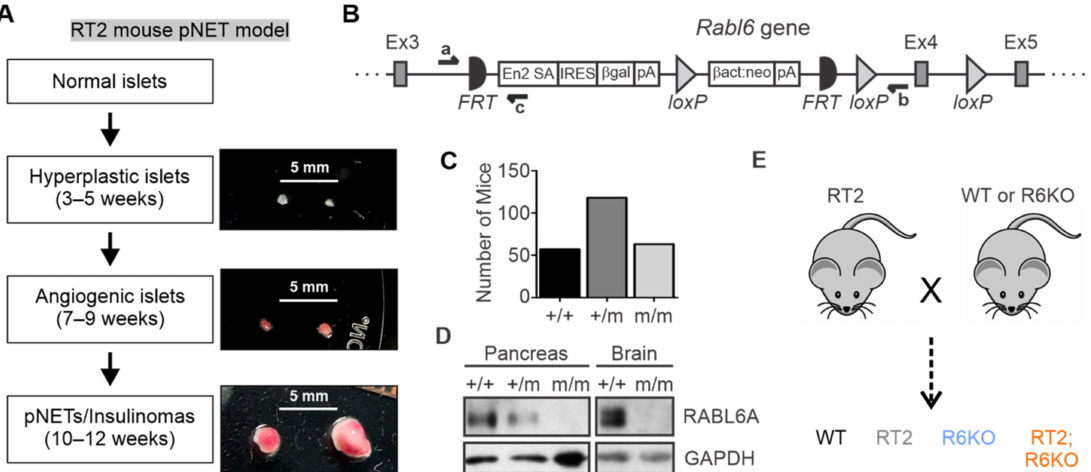
Figure 1. Description of the RT2 insulinoma and Rabl6 deficient mouse models. ( A ) Schematic outlining the sequential progression of islet transformation into functional pNETs (insulinomas) in RT2 mice. Time in parentheses represent the age of RT2 mice when the indicated islets are first observed. Right: Images of each type of lesion (with scale bars) isolated from a 12-week-old RT2 male. ( B ) Diagram of the targeted Rabl6 gene locus (exons 3–5 shown) in the gene-trap knock-out mouse model. Indicated sites include FRT (Flippase recombinase), loxP (Cre-recombinase), and primers for detecting endogenous Rabl6 allele (‘a’ and ‘b’) and mutant (m) allele (‘a’ and ‘c’). ( C ) Number of mice with +/+, +/m, or m/m genotype from Rabl6+/m heterozygous mouse crossings showing a Mendelian distribution of 1:2:1. ( D ) Western blots showing loss of RABL6A protein in Rabl6m/m mouse pancreas and brain. ( E ) Simplified schematic of RT2 crosses with WT or Rabl6m/m (R6KO) mice over multiple generations to obtain the experimental cohorts (WT, RT2, R6KO, and RT2;